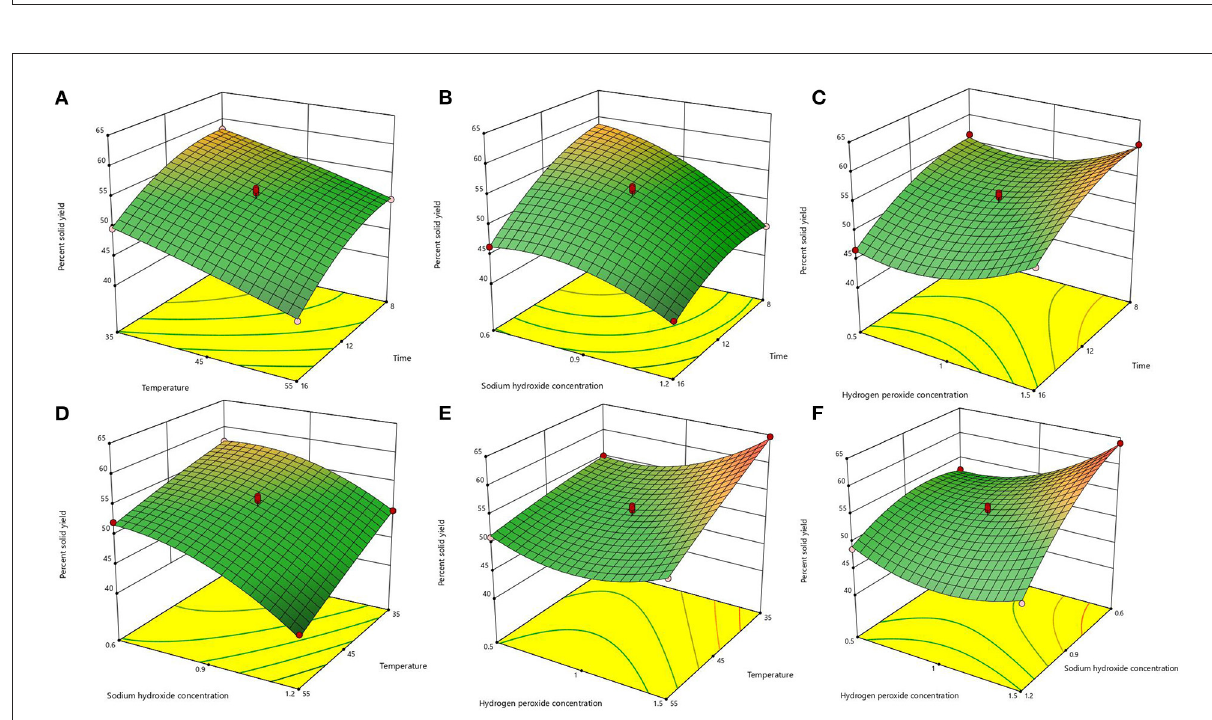
FIGURE2 Response surface plots of the interaction for solid yield. (A) temperature and time; (B) sodium hydroxide concentration and time; (C) hydrogen peroxide concentration and time; (D) sodium hydroxide concentration and temperature; (E) hydrogen peroxide concentration and temperature; (F) hydrogen peroxide concentration and sodium hydroxide